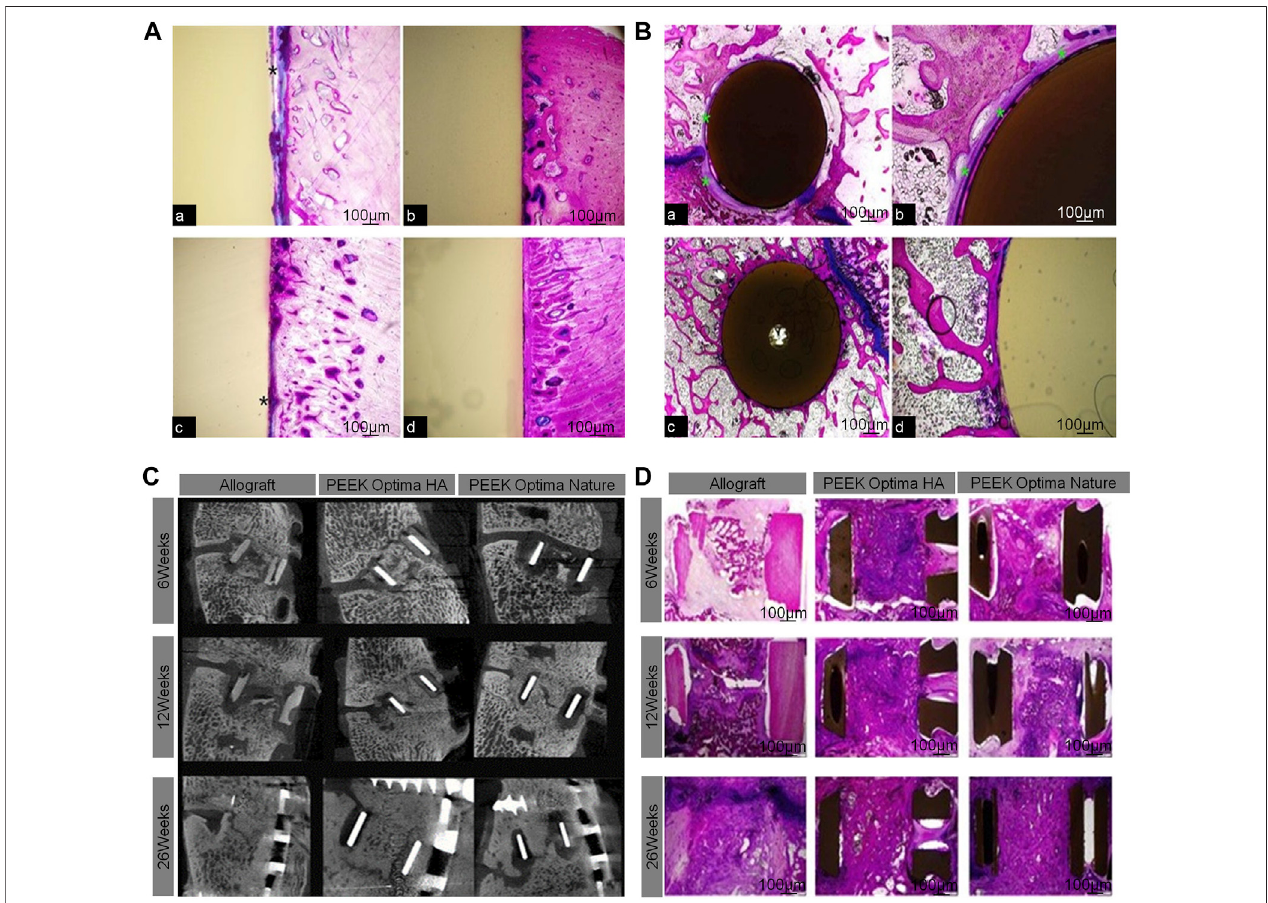
FIGURE 5 | (A) Bone ingrowth in cortical sites for PEEK cage (A,C) and PEEK-HA cage (B,D) at 4 and 12 weeks demonstrated the presence of a fi brous tissue interface for PEEK (*), whereas a direct bone-to-implant interface was observed for PEEK-HA at the magni fi cation used. (B) Bone ingrowth in cancellous sites for PEEK (A,C) andPEEK-HA (B,D) at12 weeksdemonstratedthepresenceofa fi broustissueinterfaceforPEEK(*),whereasadirectbone-to-implantinterfacewasobservedfor PEEK-HA at the magni fi cation used. (C) Micro-CT at 6, 12, and 26 weeks for allograft, PEEKHA, and PEEK demonstrated progression in fusion versus time for all groups. (D) Macroscopic overview of PMMA histology (Walsh et al.,